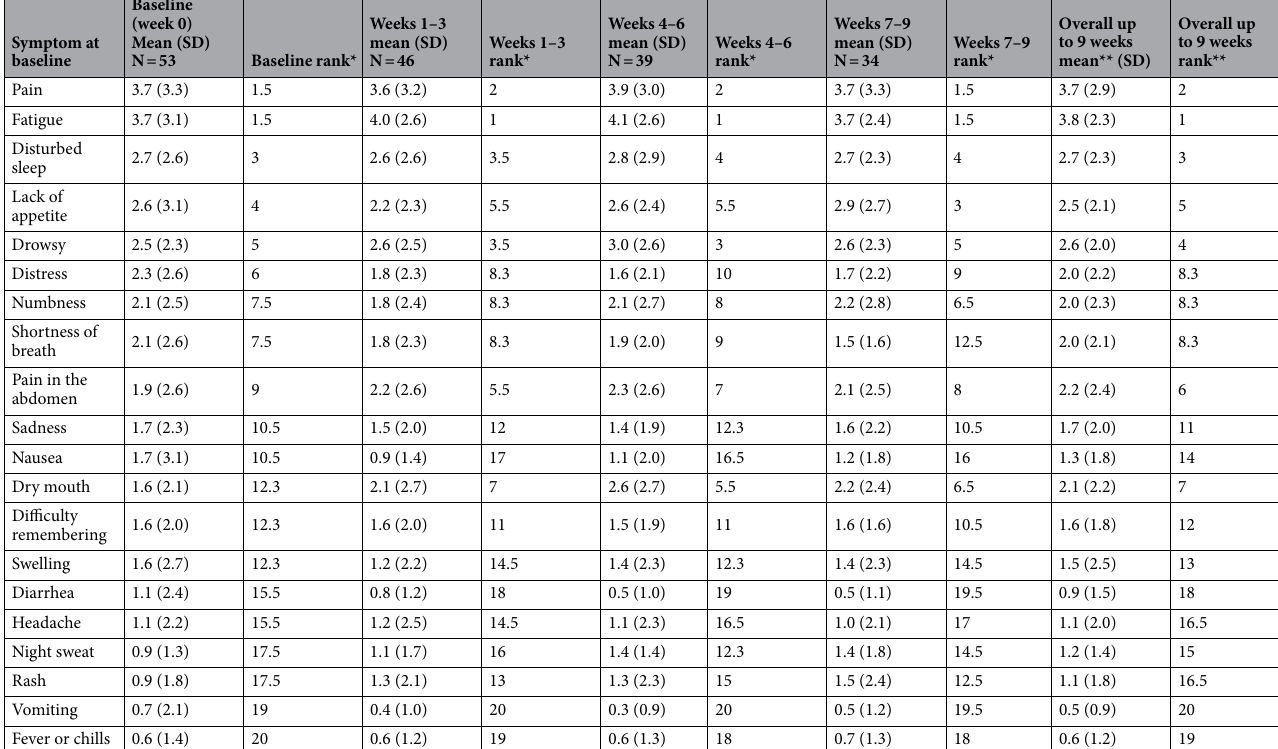
Table 2. Mean (SD) symptom severity * at baseline, at weeks 1–3, at weeks 4–6, weeks 7–9, and overall from baseline to week 9 of treatment with pembrolizumab in patients with rare solid tumors. *Symptoms at each time (at baseline, at weeks 1–3, at weeks 4–6, weeks 7–9, and overall from baseline to 9 weeks of treatment) are ranked at that respective time point. **For the calculation of the overall mean of symptom severity for each symptom over the entire treatment course from baseline to 9 weeks, the aggregated mean for each patient was first calculated prior to computing the means for the overall sample. Aggregated means were obtained for each patient prior to calculating the symptom severity at each specific time point for all patients for whom data were available at that time